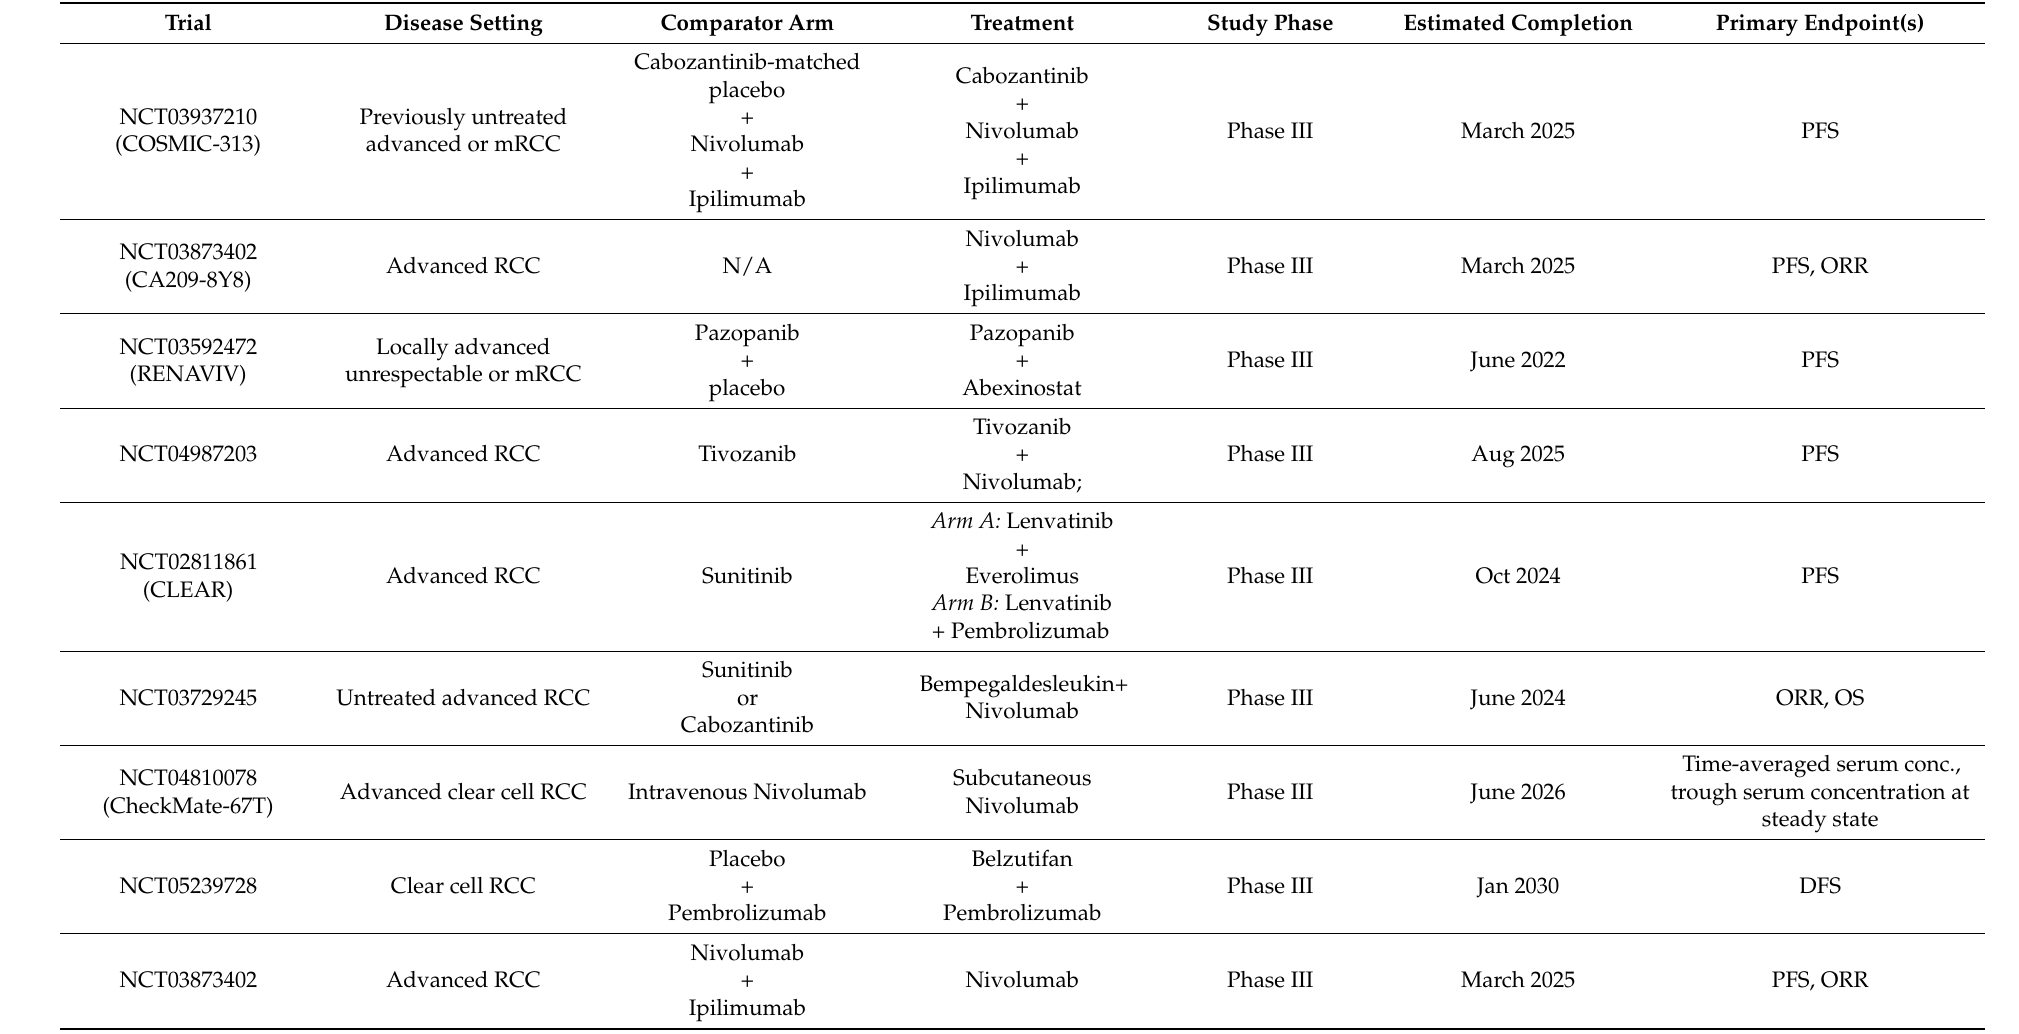
Table 4. Future therapies and ongoing clinical